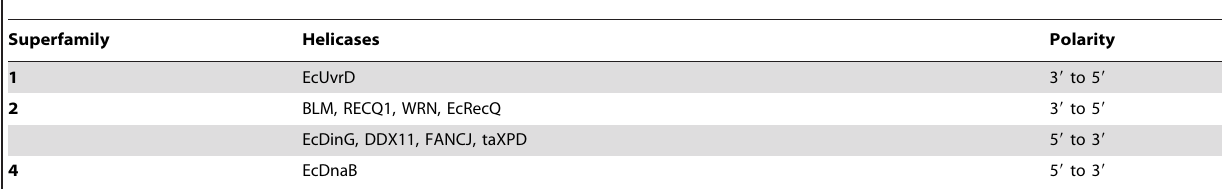
Table 1. DNA Helicases used in this